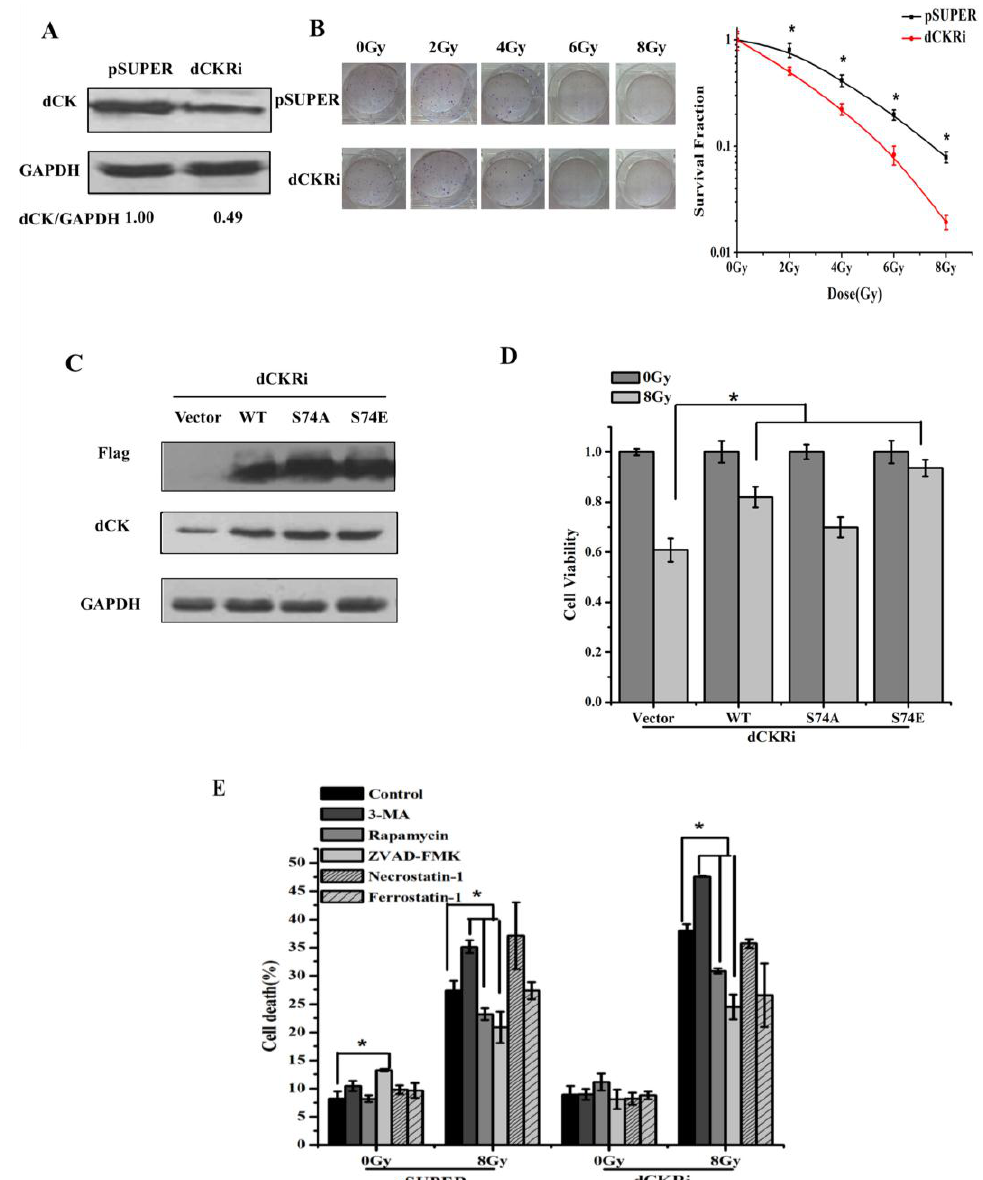
Figure 1. Deoxycytidine kinase (dCK) decreased radiation-induced cell death. ( A ) Establishment of dCK knock-down cells. Human cervical carcinoma cell line (HeLa) cells were stably transfected with pSUPER control or dCK shRNA. Individual clones were obtained under puromycin selection. Knock-down effects were confirmed by Western blot. Data were presented as mean ± SD of three independent experiments; ( B ) radiosensitivity was assessed by the colony formation assay in both dCK silencing cells and control cells after radiation treatment (0–8 Gy). Data were presented as mean ± SD of three independent experiments. * p < 0.05 versus control group or dCK silencing group; ( C ) dCK knock-down HeLa cells were reintroduced with vector control, dCK wild-type, dCK S74A mutant or S74E mutant. Overexpression of different dCK genotypes were shown by Western blot in HeLa cells. Data were presented as mean ± SD of three independent experiments; ( D ) the cells with different dCK genotypes were treated with 8 Gy radiation. Cell viability was analyzed by CCK-8 assay. * p < 0.05 versus control group; ( E ) the pSUPER and dCK knock-down cell lines were pretreated with 3-MA (2 mM), rapamycin (200 nM), ZVAD-FMK (10 μM), Necrostatin-1 (10 μM) or Ferrostatin-1 (5 μM) for 1 h, respectively, followed by ionizing radiation (IR) (8 Gy). After 48 h, cells were stained with trypan blue and analyzed by flow cytometry assay. * p < 0.05 versus control group.